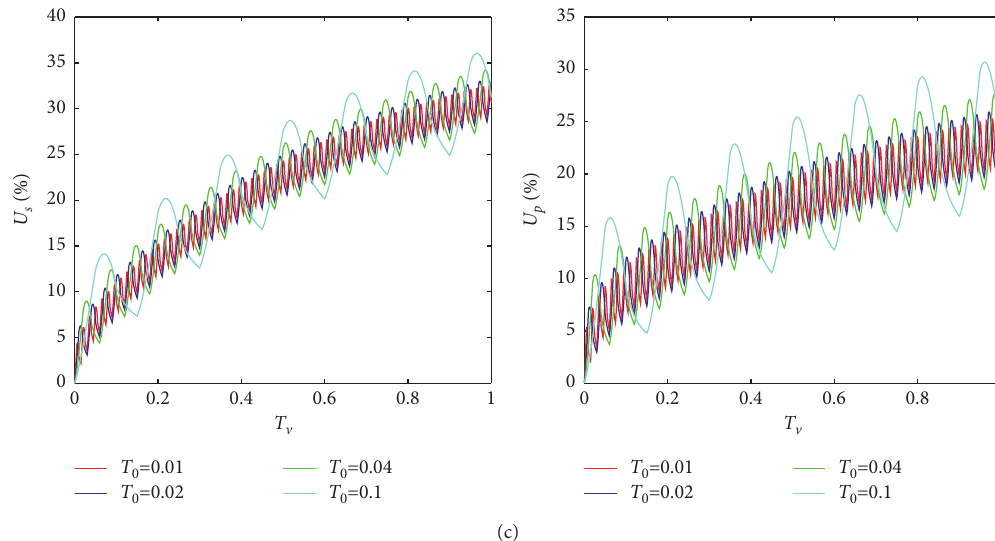
Figure 15: The variations of average degrees of consolidation U